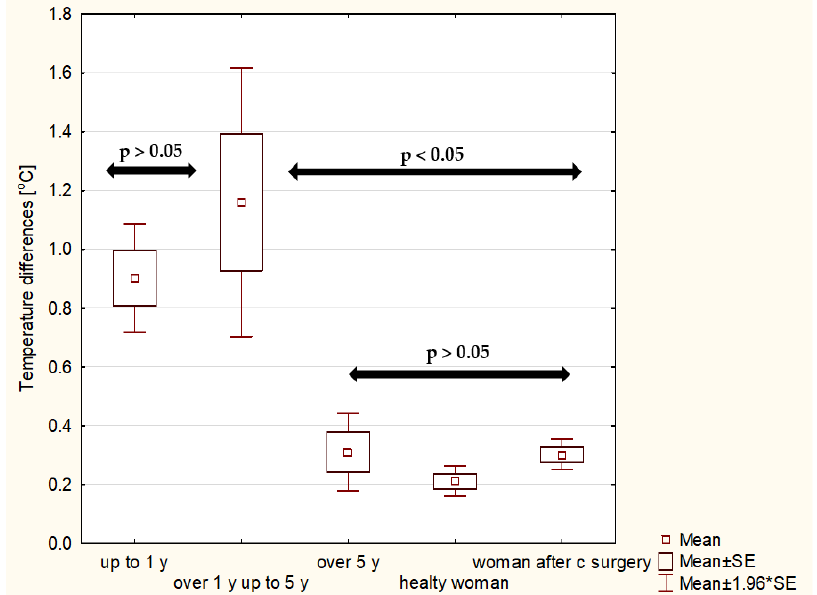
Figure 6. The average temperature difference for irradiated patients after surgery obtained between breasts in three time intervals: up to 1 year ago, over 1 year and up to 5 years and over 5 years ago for patients after surgery. The results for healthy women and women after conserving surgery have been added to the comparison.